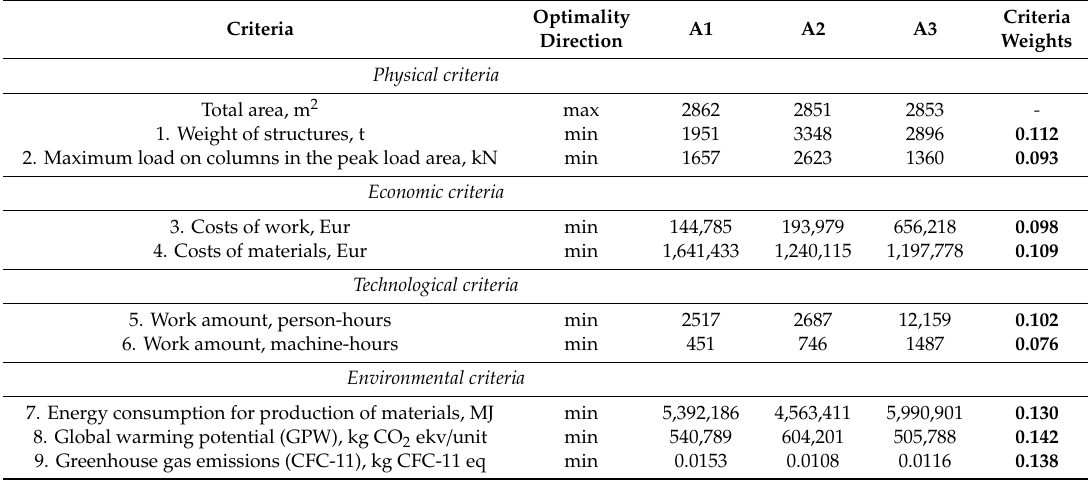
Table 6. Initial data for multi-criteria analysis.